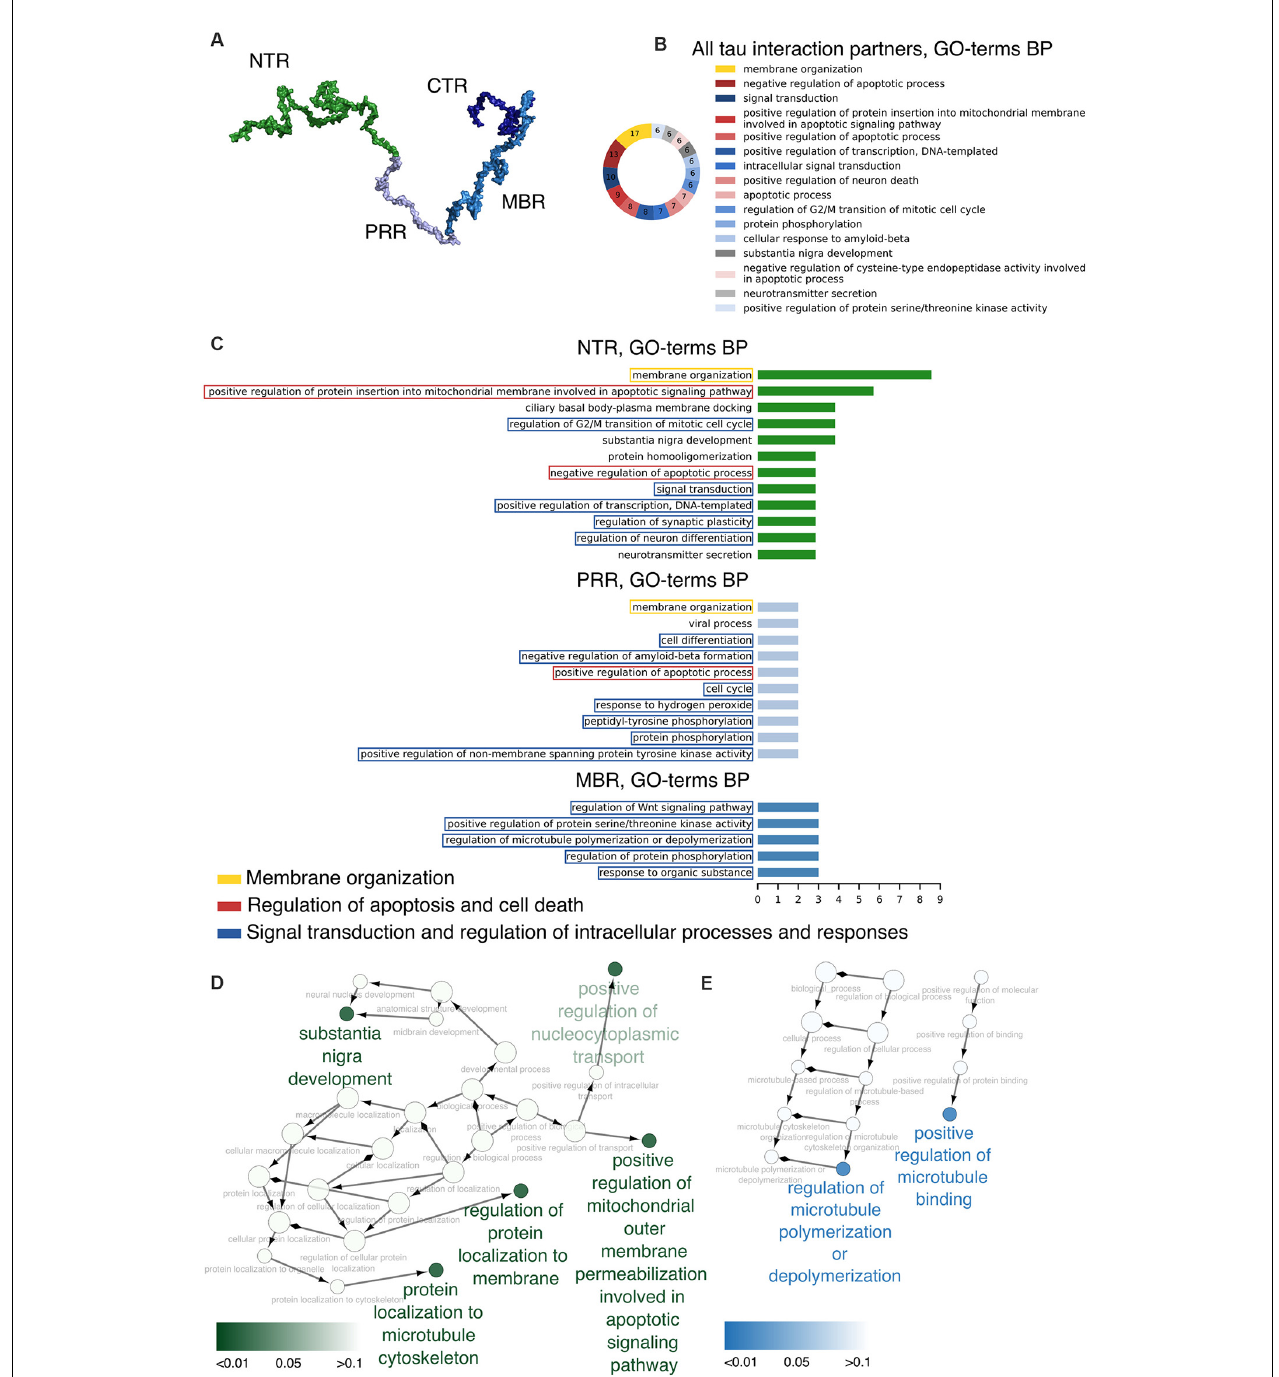
FIGURE 1 | Distinct regions of tau show functional specialization in their molecular interactions. (A) A potential 3D structure of tau [441 amino acid (aa) central nervous system (CNS) isoform] generated by the Random Coil Generator (RCG; Jha et al., 2005) is shown. Tau’s region organization was mapped onto the model and regions were color-coded as follows: amino-terminal region (NTR, 1–171)—green; proline-rich region (PRR, 172–243)—light blue; microtubule-binding region (MBR, 244–368)—blue; carboxy-terminal region (CTR, 369–441)—dark blue. (B) Most common Gene Ontology (GO)-terms for biological processes (BP) of tau’s interaction partners are shown. (C) Bar plots indicate most frequent GO-terms for BP associated with interaction partners of tau, which have been mapped to interact with the NTR, PRR and MBP. Processes associated with membrane organization are shown in yellow boxes, with apoptosis and cell death-related processes in red boxes, and with signaling and complex regulation processes in blue boxes. (D,E) GO-term enrichment analysis for genes identified as interaction partners of tau’s NTR (D) and MBR (E) was performed. Enriched GO-terms for BP are presented in the graph. Enrichment analysis was performed for Homo sapiens genes.